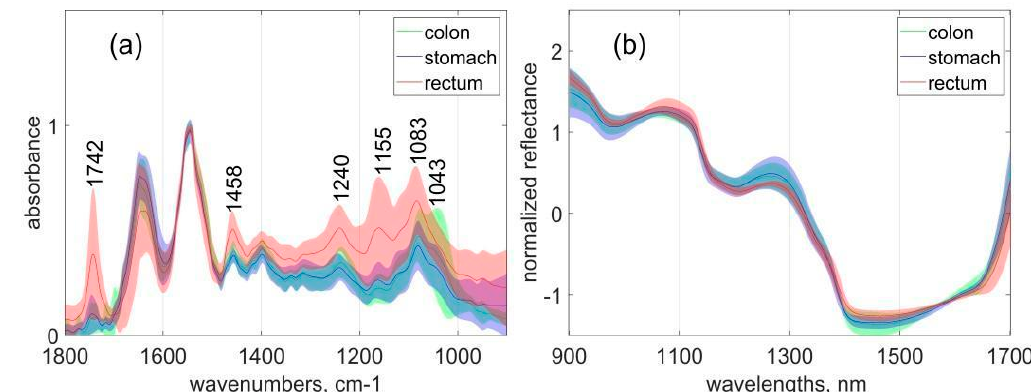
Figure 1. The mean spectra and the intervals of standard deviation for normal colon, stomach, and rectum samples: ( a ) unpreprocessed mid-infrared (MIR) spectra; ( b ) smoothed standard normal variate correction (SNV)-normalized near-infrared (NIR) spectra. The curves and the surrounding coloured regions represent the mean spectra and the standard deviation intervals of the respective data variables.